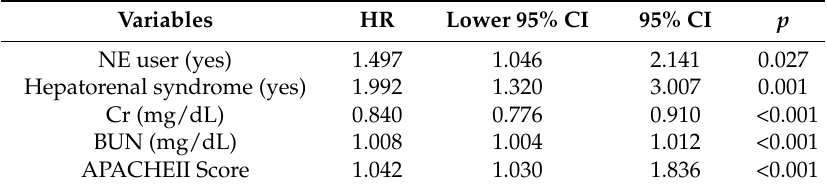
Table 2. Cox regression for 90-day m4.ortality in septic shock patients with NE or other vasoactive agents at dialysis initiation *.